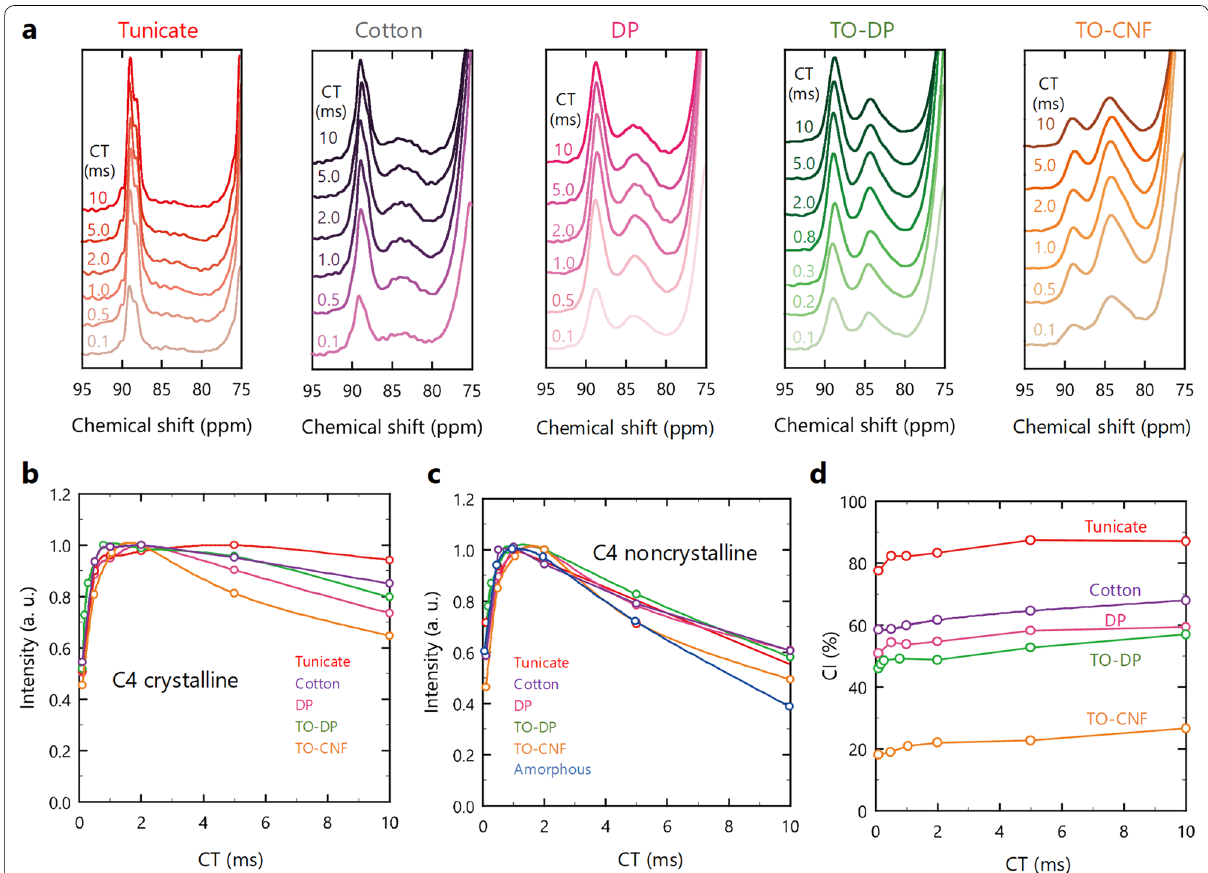
Fig. 1 a NMR spectra of a series of samples at several CTs. The Scherrer crystal sizes of the acid hydrolysates of tunicin and cotton, DP, TO-DP, and TO-CNF were 10, 6.5, 4.0, 3.6, and 2.0 nm, respectively. b Dependency of CT on the signal intensity corresponding to the C4 crystalline region. c Dependency of CT on the signal intensity corresponding to the C4 noncrystalline region. d Dependency of CT on the CI